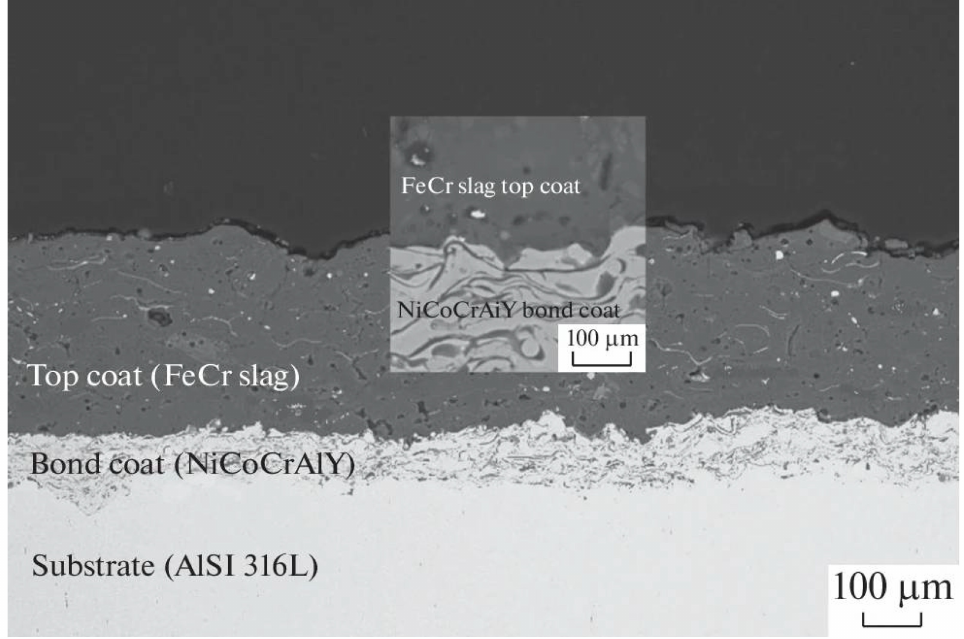
Figure 11. Cross-sectional SEM image of FeCr slag coating as an alternative coating material for caster rolls a continuous casting line. Adapted with permission from [9]. 2022, Springer